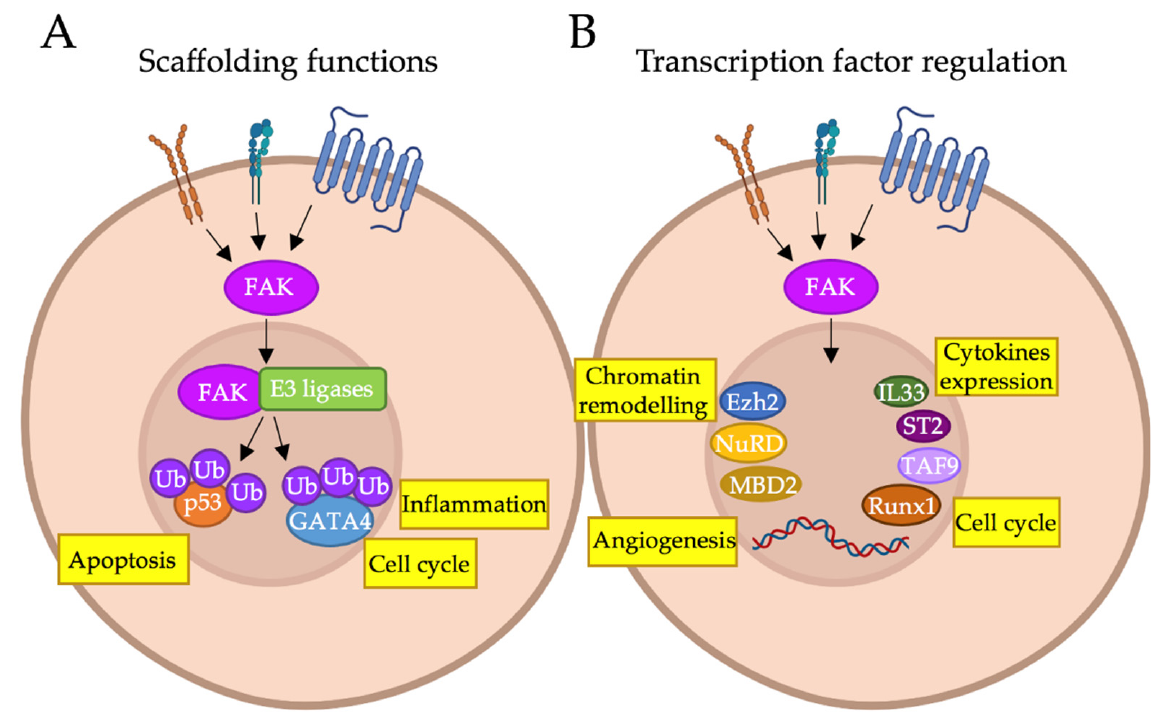
Figure 2. FAK functions in the nucleus. Graphical representation of the nuclear functions of FAK and its interactors. ( A ) FAK acts as a scaffold to stabilize complexes between p53 or GATA4 and the ubiquitin E3 ligases Mdm2 or CHIP, respectively. This leads to p53 and GATA4 polyubiquitination and subsequent degradation by the proteasome; ( B ) FAK acts as a regulator of gene expression by controlling chromatin accessibility, acting on a variety of epigenetic modulators (MBD2, Ezh2, NuRD complex); transcriptionally regulating the expression of transcription factors, such as IL33 and ST2; or forming molecular complexes with transcription factors such as TAF9 and Runx1. By regulating gene expression, nuclear FAK can be involved in apoptosis, inflammation, cell cycle, angiogenesis and cytokine expression. Figure realized with BioRender software (https://biorender.com/, accessed on 27 December 2021).